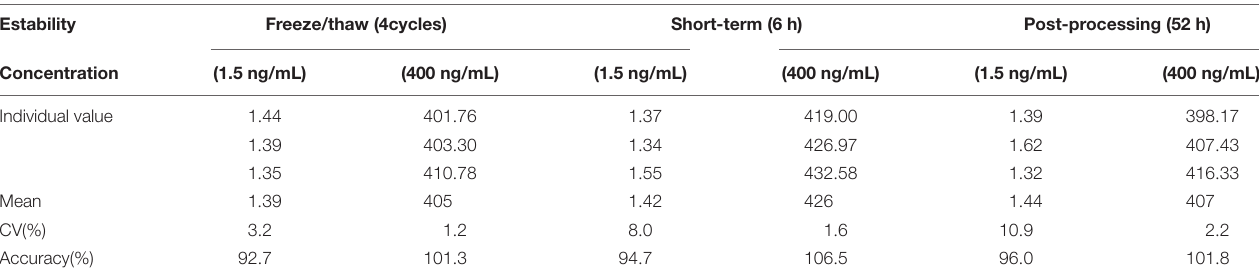
TABLE 3 | Stability tests for neurounina-1 in beagle dog plasma.